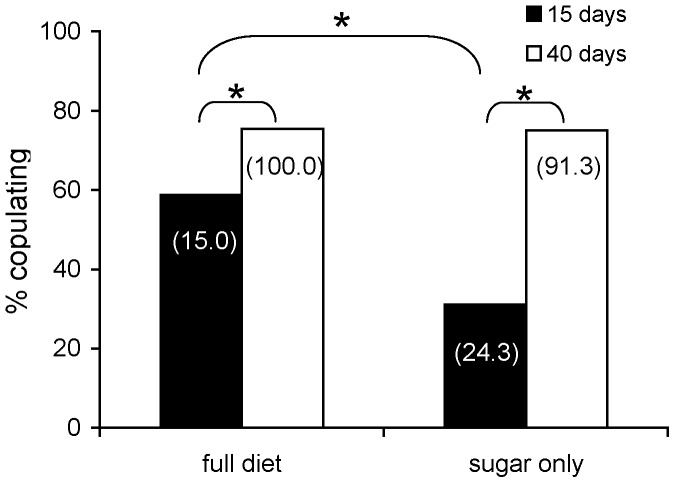
Copulation success of females fed a full (left) and a protein-deprived (right) diet, at a young (15 days) and an old (40 days) age.The percentage of the females that had initiated egg production one day before the mating test is given in parenthesis. Asterisks (*) indicate significant differences (P<0.05).